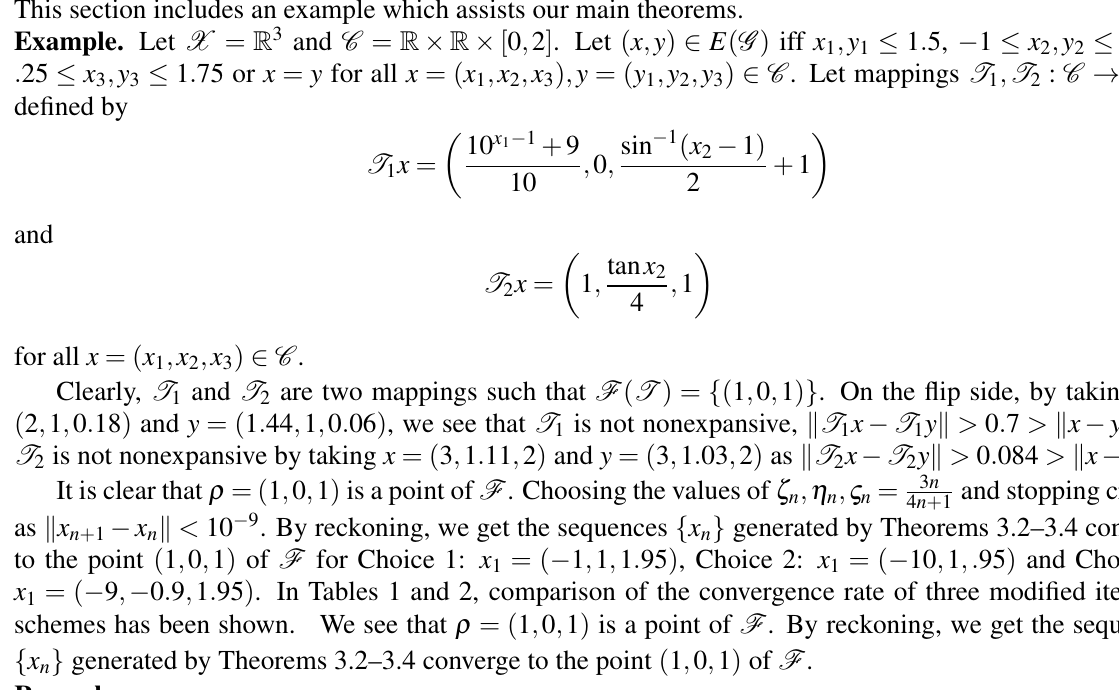
Table 1. For Choices 1 and 2, comparison for the sequences defined in Theorems 3.2–3.4